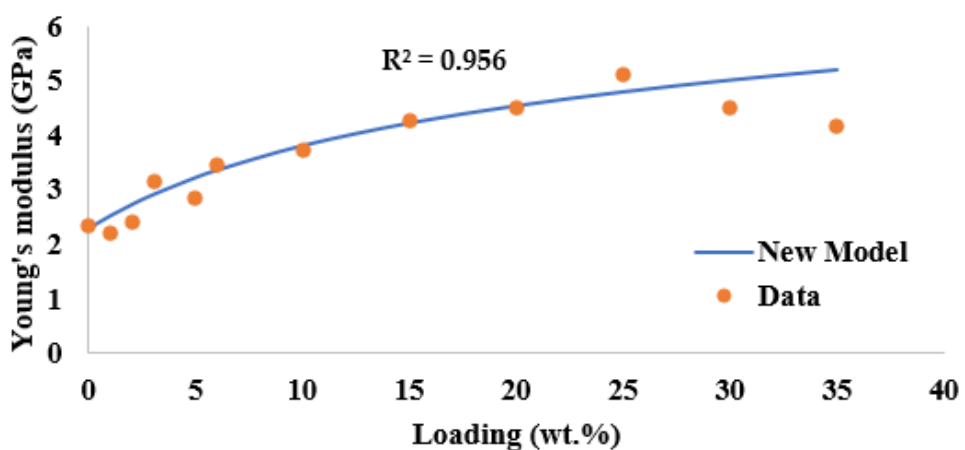
Figure 6. Comparison between the new model and experimental